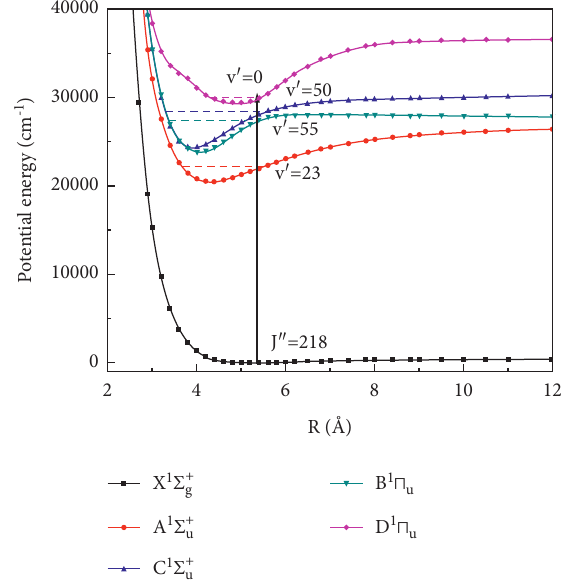
Figure 4: The selected optimally vibrational target states of excited states of Yb 2 .